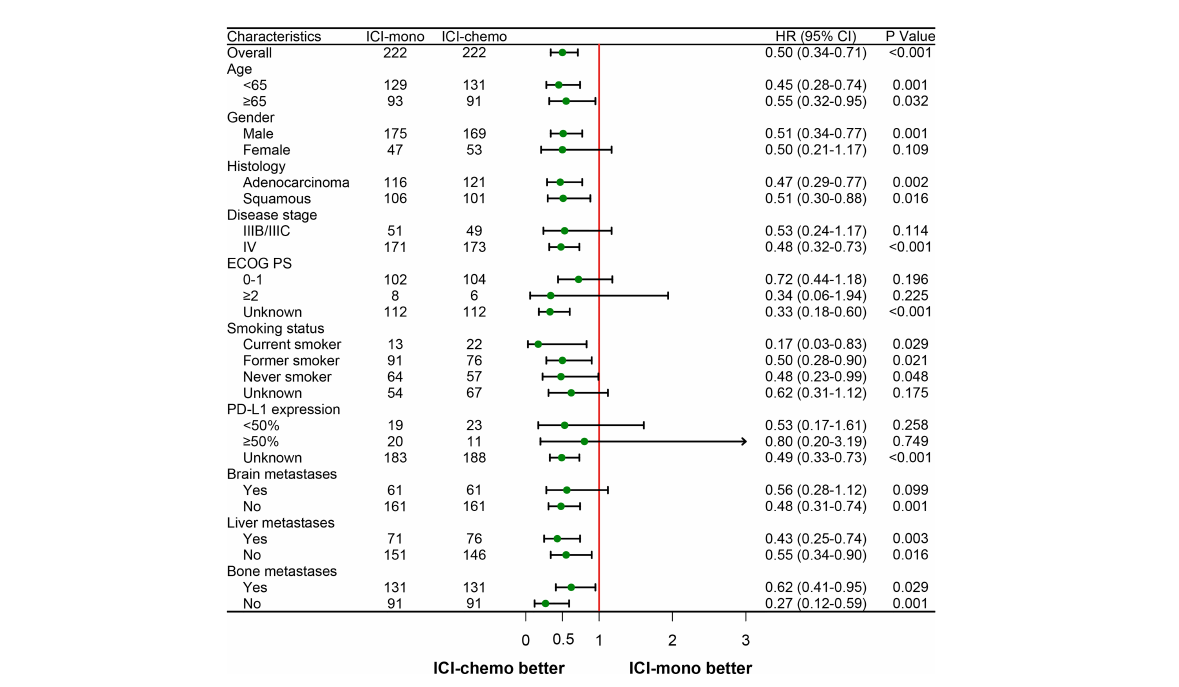
FIGURE 4 Forest plot of hazard ratios for overall survival by prespeci fi ed subgroups after propensity score matching. HR, hazard ratio; ECOG PS, Eastern Cooperative Oncology Group performance status; PD-L1, programmed death ligand